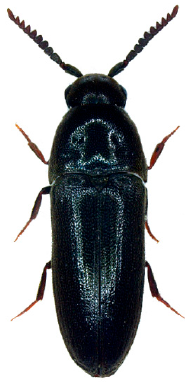
Figure 1. Eucnemis capucina (foto Leica) .